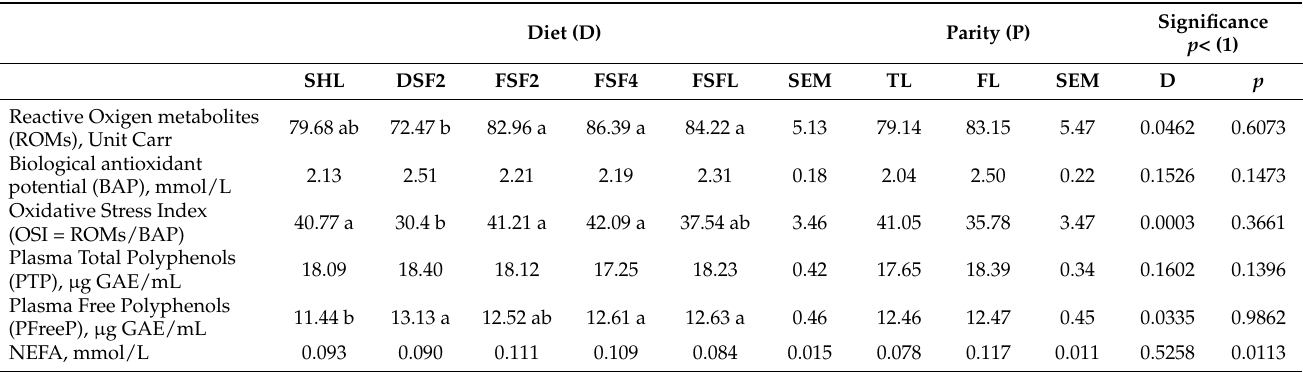
Table 4. Effect of diet and parity on oxidative status biomarkers, plasma polyphenols, and NEFA in